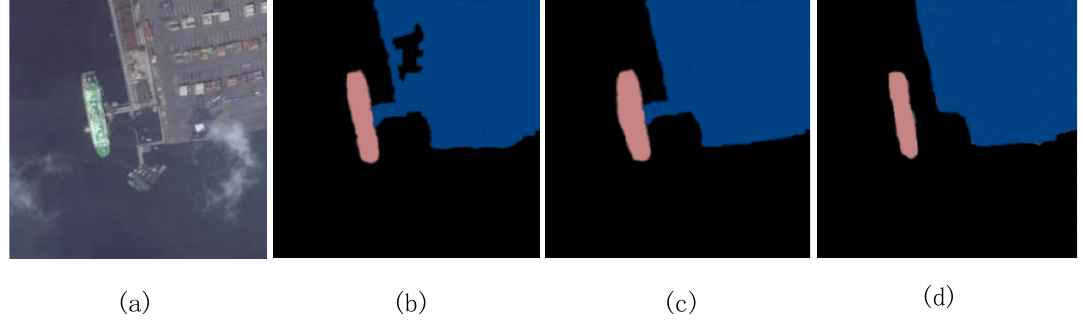
Figure 8. Semantic segmentation of ships under thin clouds. ( a ) Original ( b )CRF-RNN ( c ) DeepLab ( d ) Proposed model.